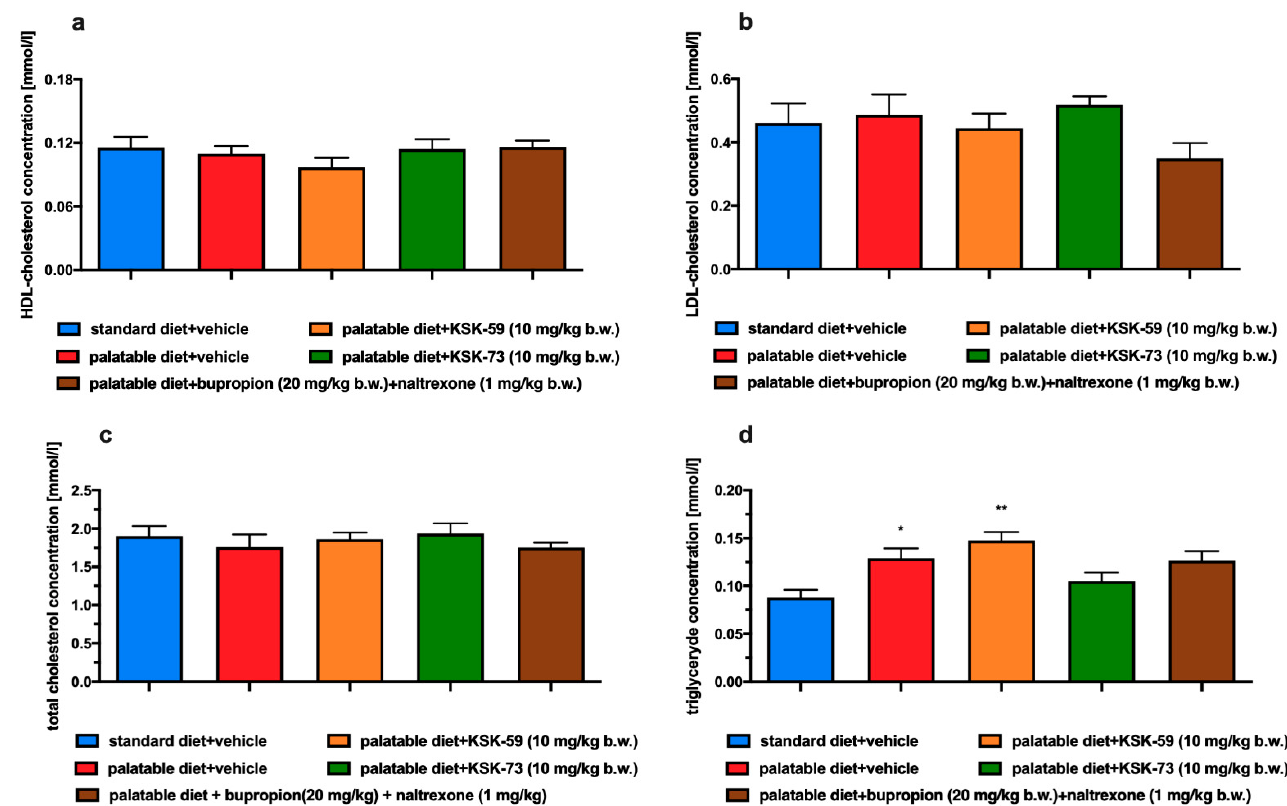
Figure 5. Effect of the tested compounds or bupropion/naltrexone administration on plasma levels of: ( a ) total cholesterol, ( b ) LDL cholesterol, ( c ) HDL-cholesterol, ( d ) triglyceride. Results are expressed as means ± SEM, n = 6. Comparisons were performed by one-way ANOVA, Tukey’s post hoc test. * Significant against control rats fed standard diet; * p < 0.05, ** p < 0.01.